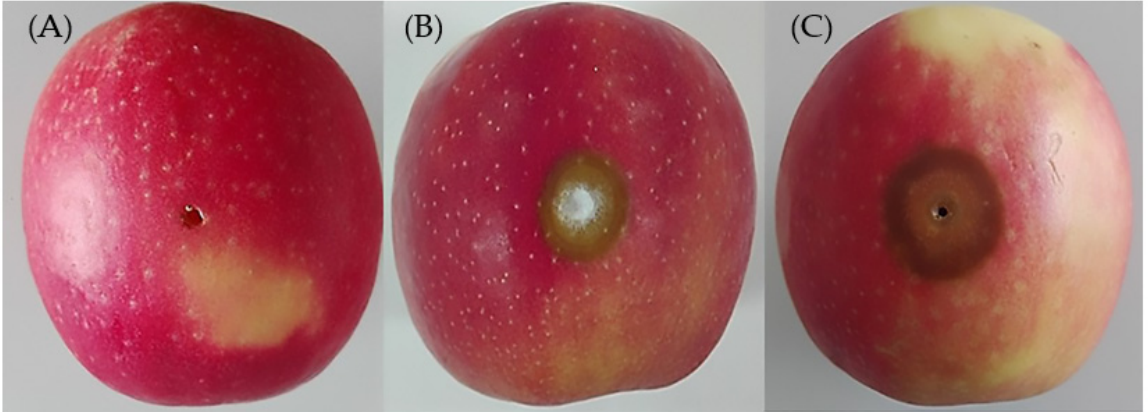
Figure 4. Disease severity of Chilean CP13 isolate of Phlyctema vagabunda in ‘Cripps Pink’ apples inoculated with sterile distilled water ( A ), mycelium disc ( B ), and conidia suspension ( C ). The fruit was incubated at 20 °C for 20 days.